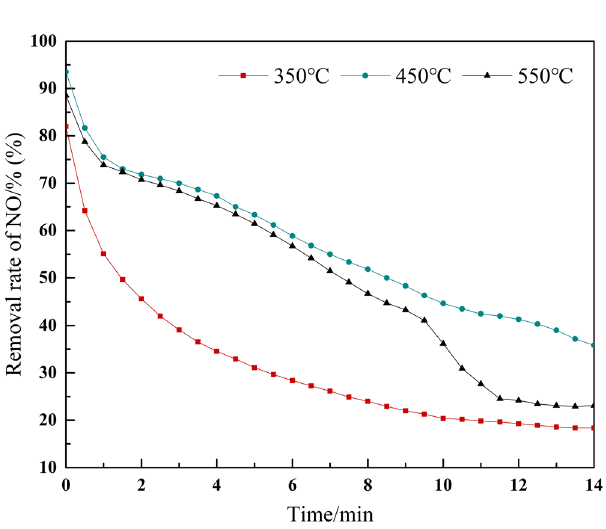
Figure 5. Influence of different calcination time of muffle furnace on NO removal efficiency.